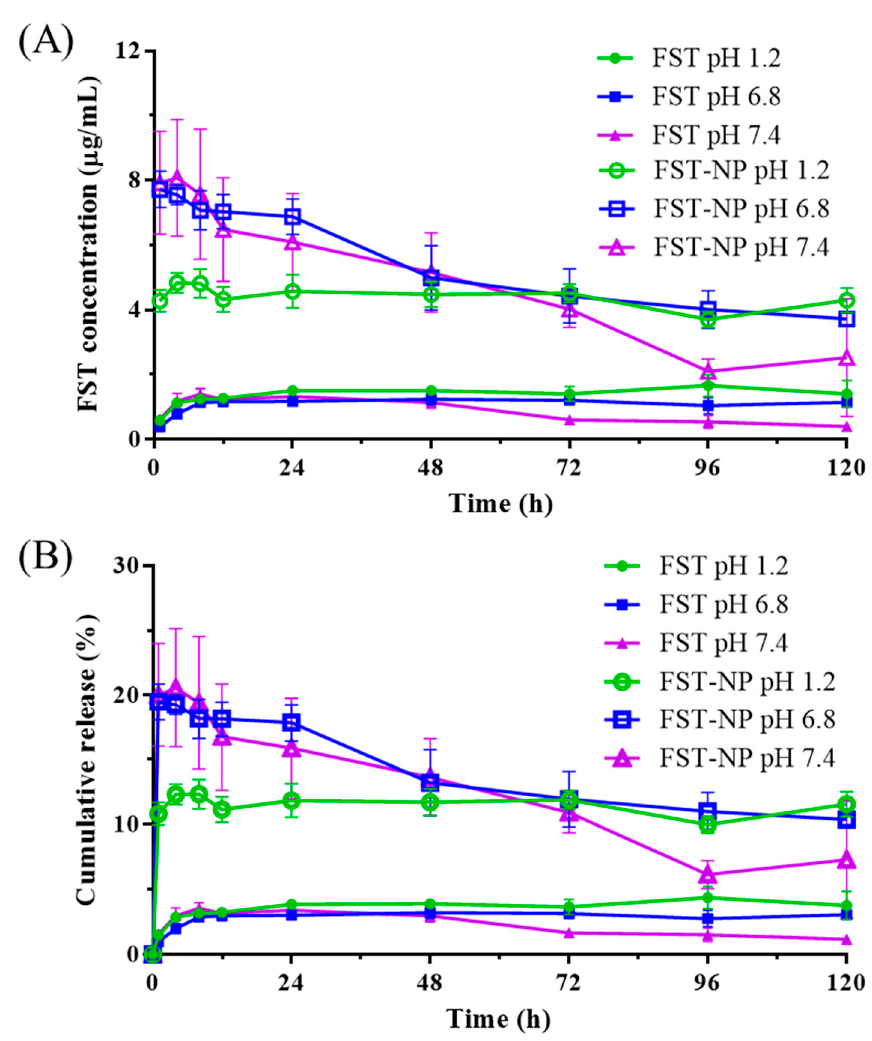
Figure 8. The in vitro release profile of FST and FST–NP in the pH 1.2, 6.8, and 7.4 medium by presenting ( A ) concentration and ( B ) percentage of cumulative release. Data are expressed as mean ± standard deviation ( n = 3). Green solid and hollow circle present FST and FST–NP in pH 1.2, blue solid and hollow square present FST and FST–NP in pH 6.8, and purple solid and hollow triangle present FST and FST–NP in pH